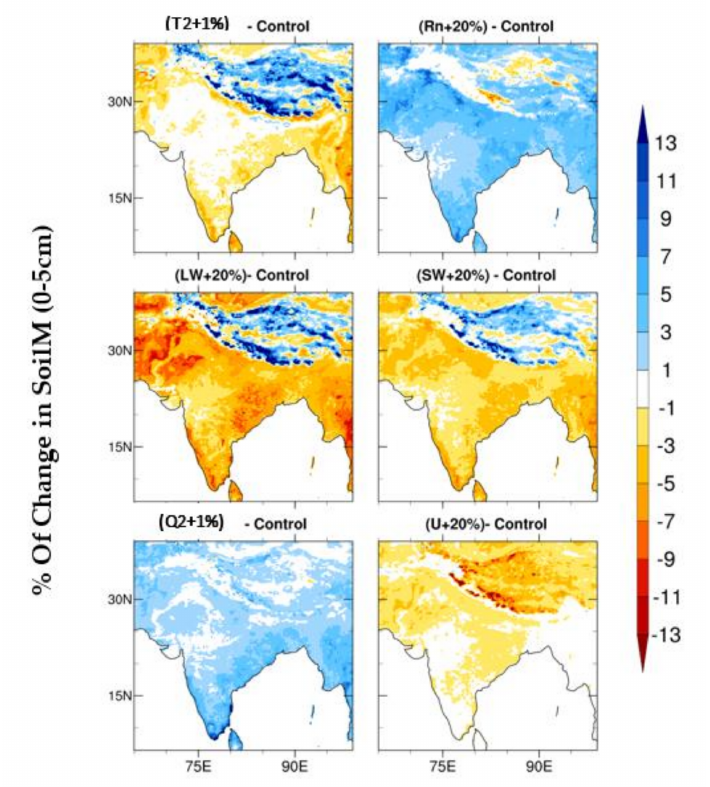
Figure 4. Soil moisture change (%) during MAM in each positive sensitive experiment compared to the control experiment during the year